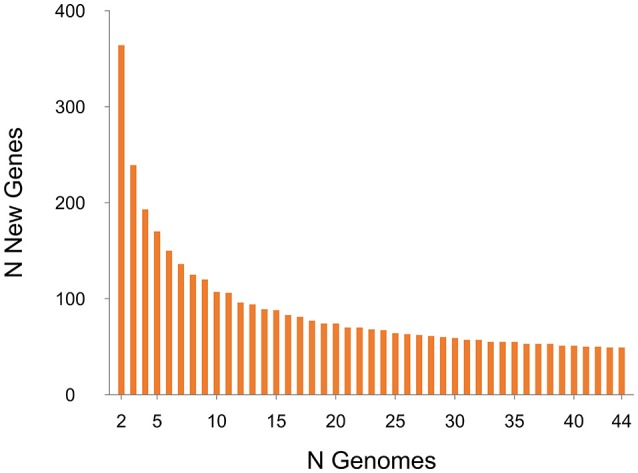
Strain-specific gene analysis for 44 C. difficile RT014 genomes. A plot of the number of new “strain-specific” genes contributing to the gene pool per additional sequenced strain as a function of the number of strains (n = 44). Consistent with an open pan-genome, the number of new genes does not converge to zero upon sequencing of additional genomes (at n = 44, an average of 48 new genes are contributed to the gene pool).